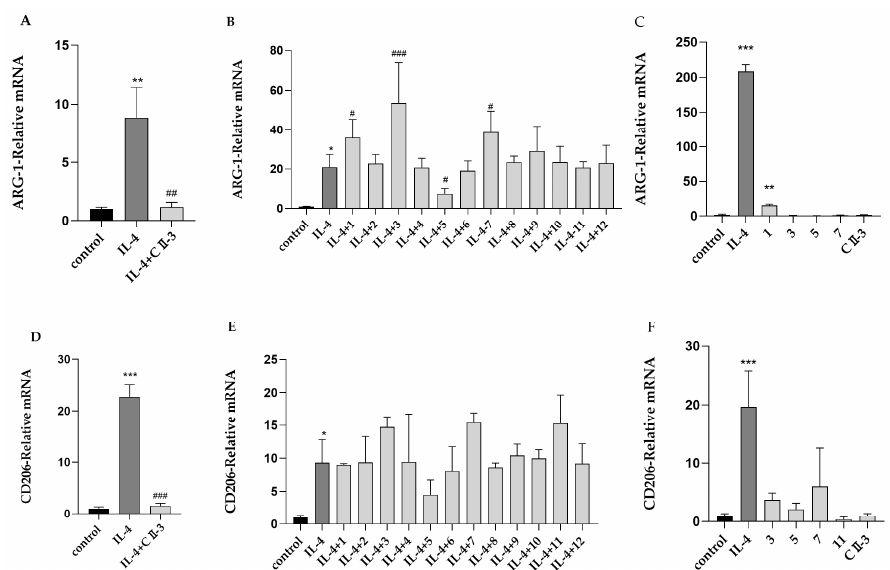
Figure 2. Expression effects of CII-3 and 12 compounds on ARG-1 and CD206 in IL-4-induced RAW 264.7 cells. ARG-1 expression affected by CII-3 ( A ), 12 compounds ( B ), and CII-3 and compounds ( 1,3,5,7 ) without IL4 pretreatment ( C ). CD206 expression effected by CII-3 ( D ), 12 compounds ( E ), and CII-3 and compounds ( 3 , 5 , 7 , 11 ) without IL-4 ( F ). * p < 0.05, ** p < 0.01, and *** p < 0.001 vs. the control group; # p < 0.05, ## p < 0.01, and ### p < 0.001 vs. the IL-4 group.